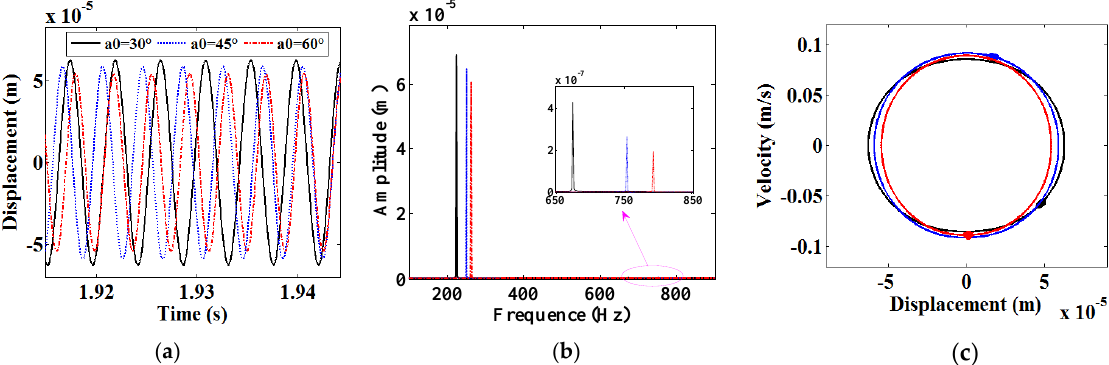
Figure 15. Vibration responses in the resonance region: ( a ) Time history; ( b ) Spectrum; ( c ) Phase diagram and Poincaré section.